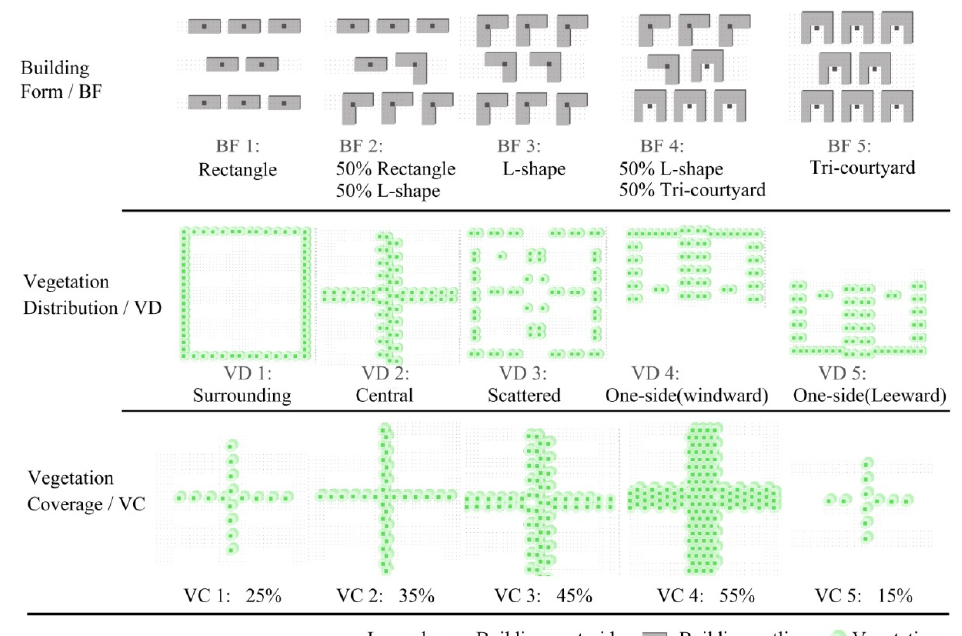
Figure 8. Experimental design levels for all factors.